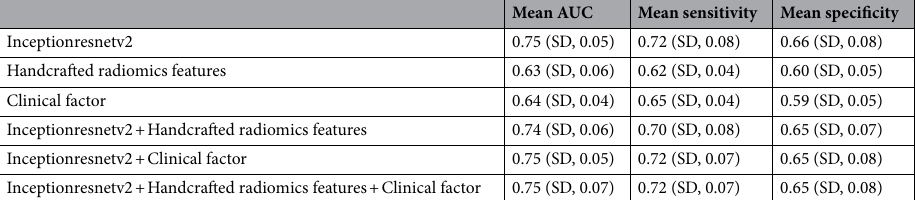
Table 1. Mean 0.632 + bootstrap areas under the curve (AUCs), sensitivity, and specificity of the deep learning-based radiomics, handcrafted radiomics features, clinical factors, and combined models for predicting primary gross tumor volume (GTVp) regression. AUC area under the curve, SD standard deviation.